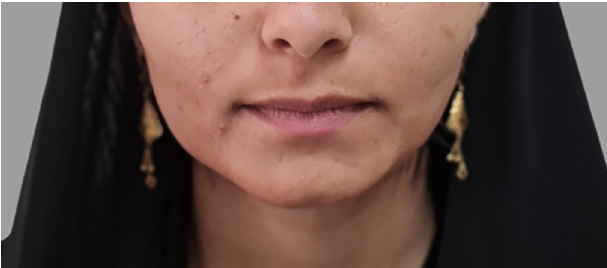
Fig. 5. One year post operation with normal appearance of mandibular